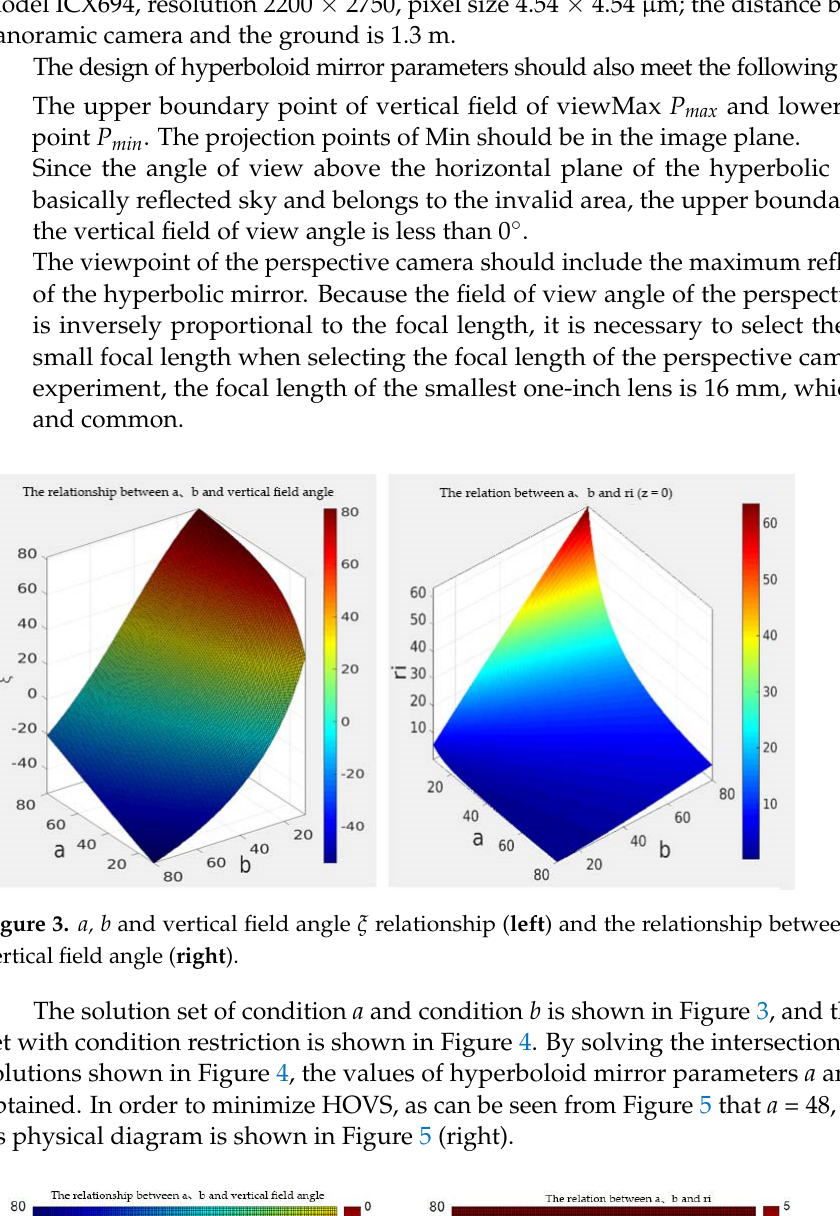
Figure 5. Feasible intersection of two solution spaces (left) and real image of mirror (right). 2. Mirror mounting disk rotation module, mirror height adjustment module, and visual positioning module.